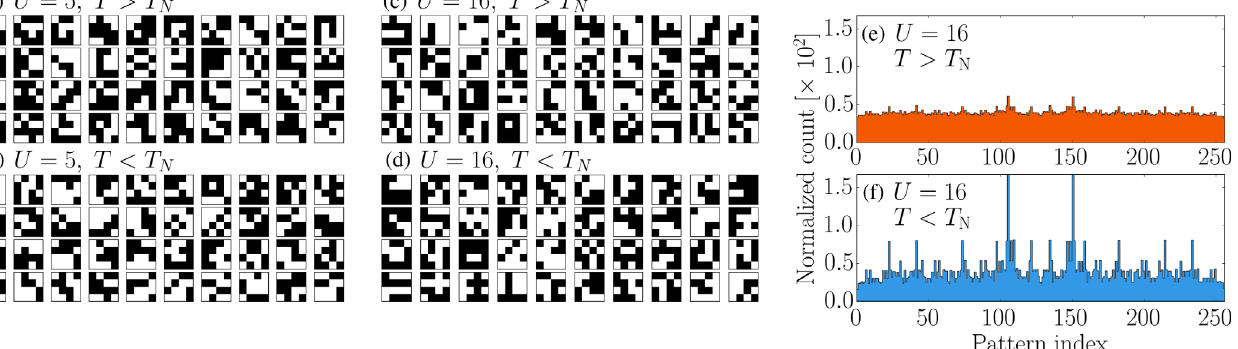
FIG. 7. (a) – (d) Typical auxiliary field patterns above and below T N used as input to the CNN for the N ¼ 4 3 system. In each panel, the four rows correspond to the four layers in the z direction. We show the field only in the first 10 imaginary time slices (left to right) for each case. (e,f) Normalized count of the 256 patterns within 2 × 2 × 2 cubes as detected in the raw configurations for U ¼ 16 below and above T N . The two largest peaks in (f) correspond to the two AFM patterns.